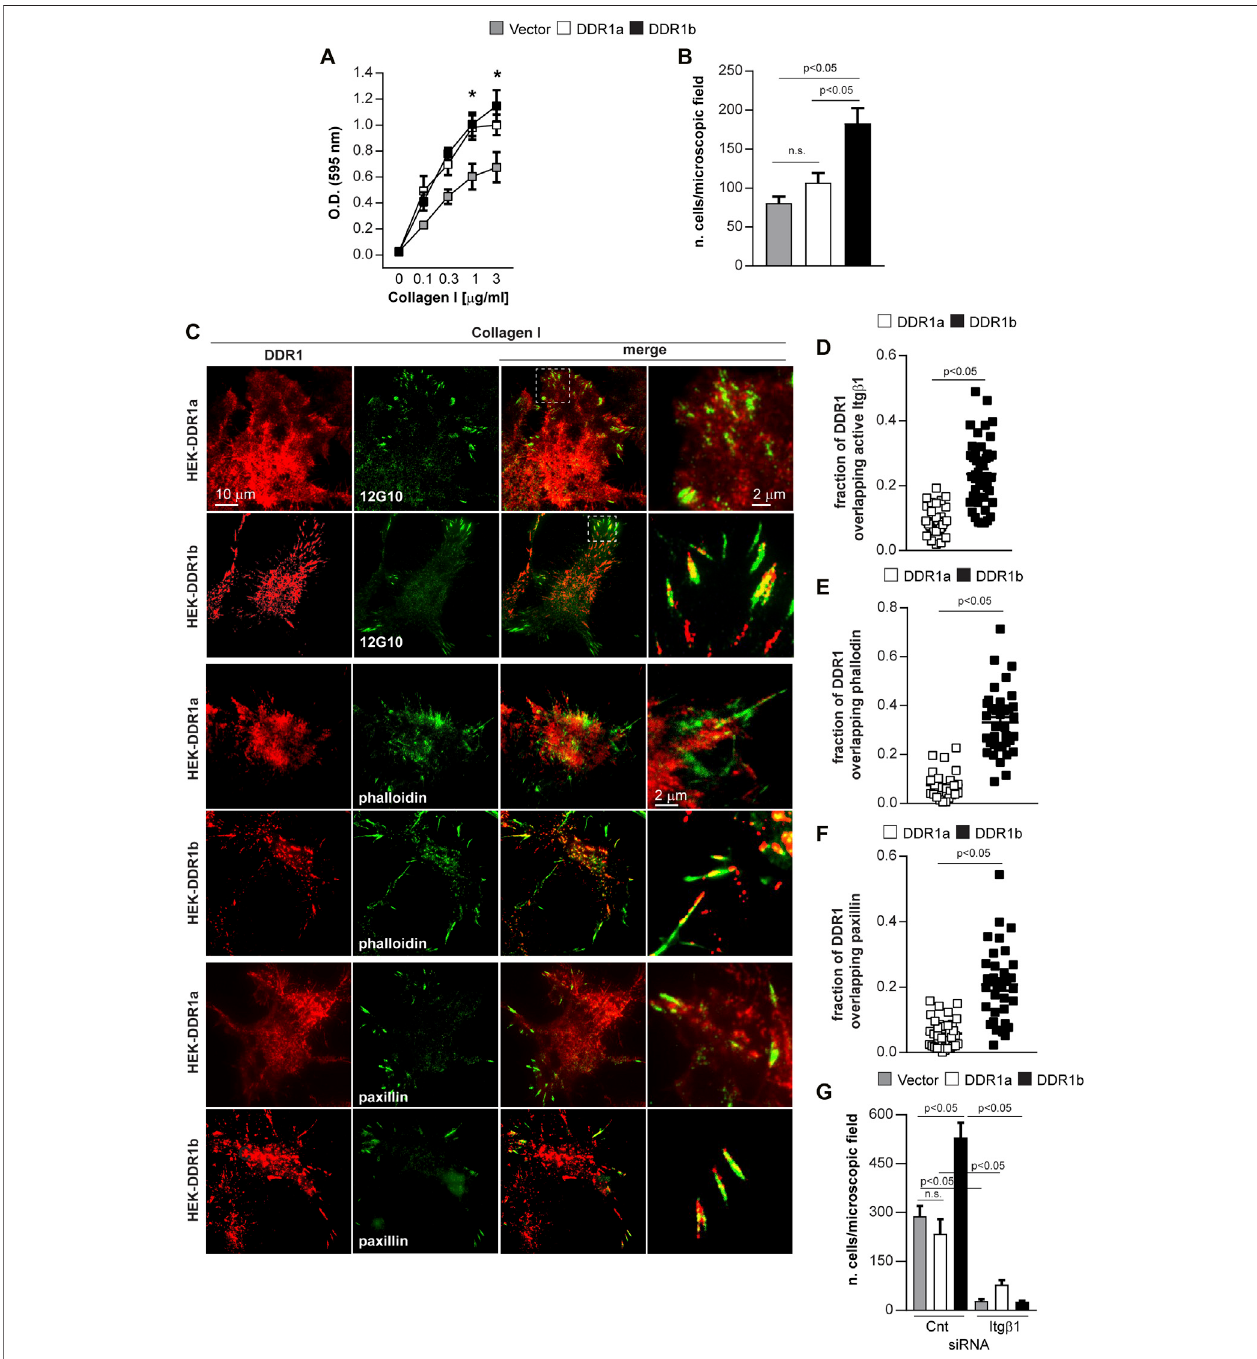
FIGURE 3 | DDR1b enhances cell migration on collagen I and localizes to focal adhesions. (A) Adhesion of Vector- DDR1a-, or DDR1b-expressing HEK cells to collagen I (0 – 3 µg/ml). Values are the mean ± SEM of 3 independent experiments performed at least in triplicate. ** p < 0.05 relative to HEK-Vector. (B) Migration of Vector- DDR1a-, or DDR1b-expressing HEK cells towards collagen I (20 μ g/ml). Values are the mean ± SEM of 3 independent experiments with at least 4-6 fi elds/ microscopic fi eld counted. Statistical analysis in (A,B): One-way ANOVA followed by Tukey ’ s multiple comparison test. (C) Total internal re fl ection fl uorescence (TIRF) microscopy of HEK-DDR1a and HEK-DDR1b cells plated on collagen I (20 µg/ml) for 1 h and then co-stained with anti-DDR1 and integrin beta 1 (12G10), FITC- phalloidin, or anti-paxillin antibodies. Overlay images reveal co-localization of DDR1b with activated integrin β 1, actin or paxillin. Co-localization of DDR1a, DDR1b with 12G10 (D) ,actin (E) ,paxillin (F) atthecellmembraneofcellsplatedoncollagenIwasdeterminedusingtheImageJ/JACoPanalysisandtheManders ’ overlapcoef fi cient (Bolte and Cordelieres, 2006). Values are the mean ± SEM of 3-4 FAs calculated for 10-13 cells and represent the fraction of DDR1 signal overlapping with 12G10 phalloidin and paxillin. Statistical analysis: unpaired two-tailed t -test. (G) Migration of Vector- DDR1a-, and DDR1b-expressing HEK cells transfected with Cnt or Itg β 1 siRNA towards collagen I (20 μ g/ml). Values are the mean ± SEM of 3 independent experiments with at least 7 fi elds/microscopic fi eld counted. Statistical analysis was done with One-way ANOVA followed by Tukey ’ s multiple comparison test.